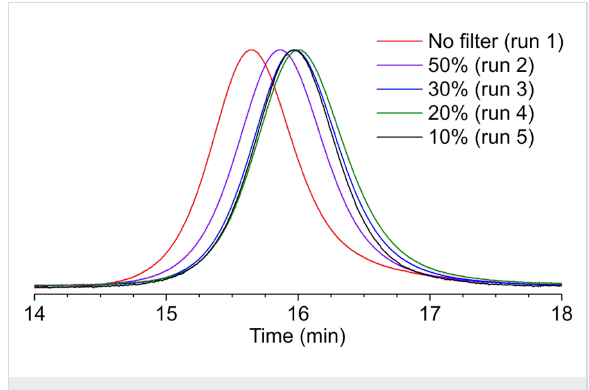
Figure 2: GPC traces for the polymerizations of MMA (Table 1). The percentages in the legend refer to the ND filters used. The synthetic scope of MMA polymerization was next exam-